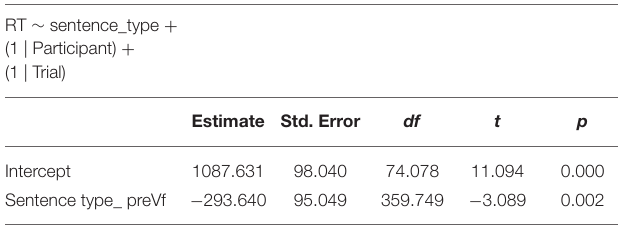
Frontiers in Psychology |